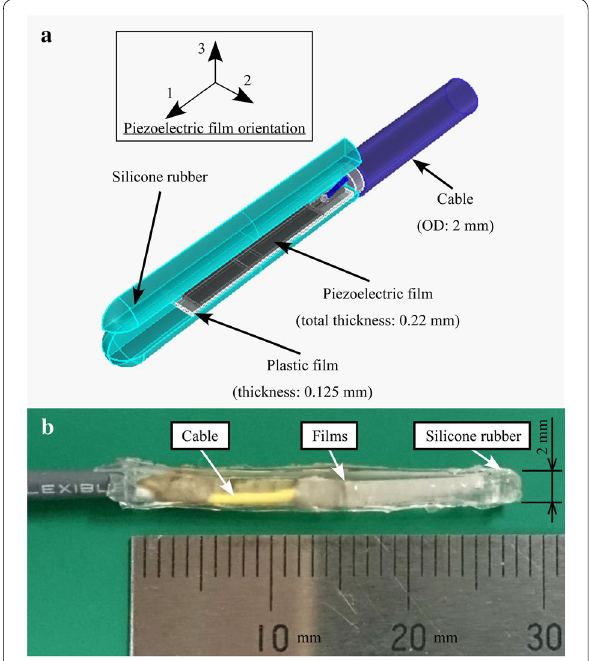
Fig. 1 Prototype of catheter-type tactile sensor with an outer diameter of 2 mm. a Schematic diagram. b Photograph